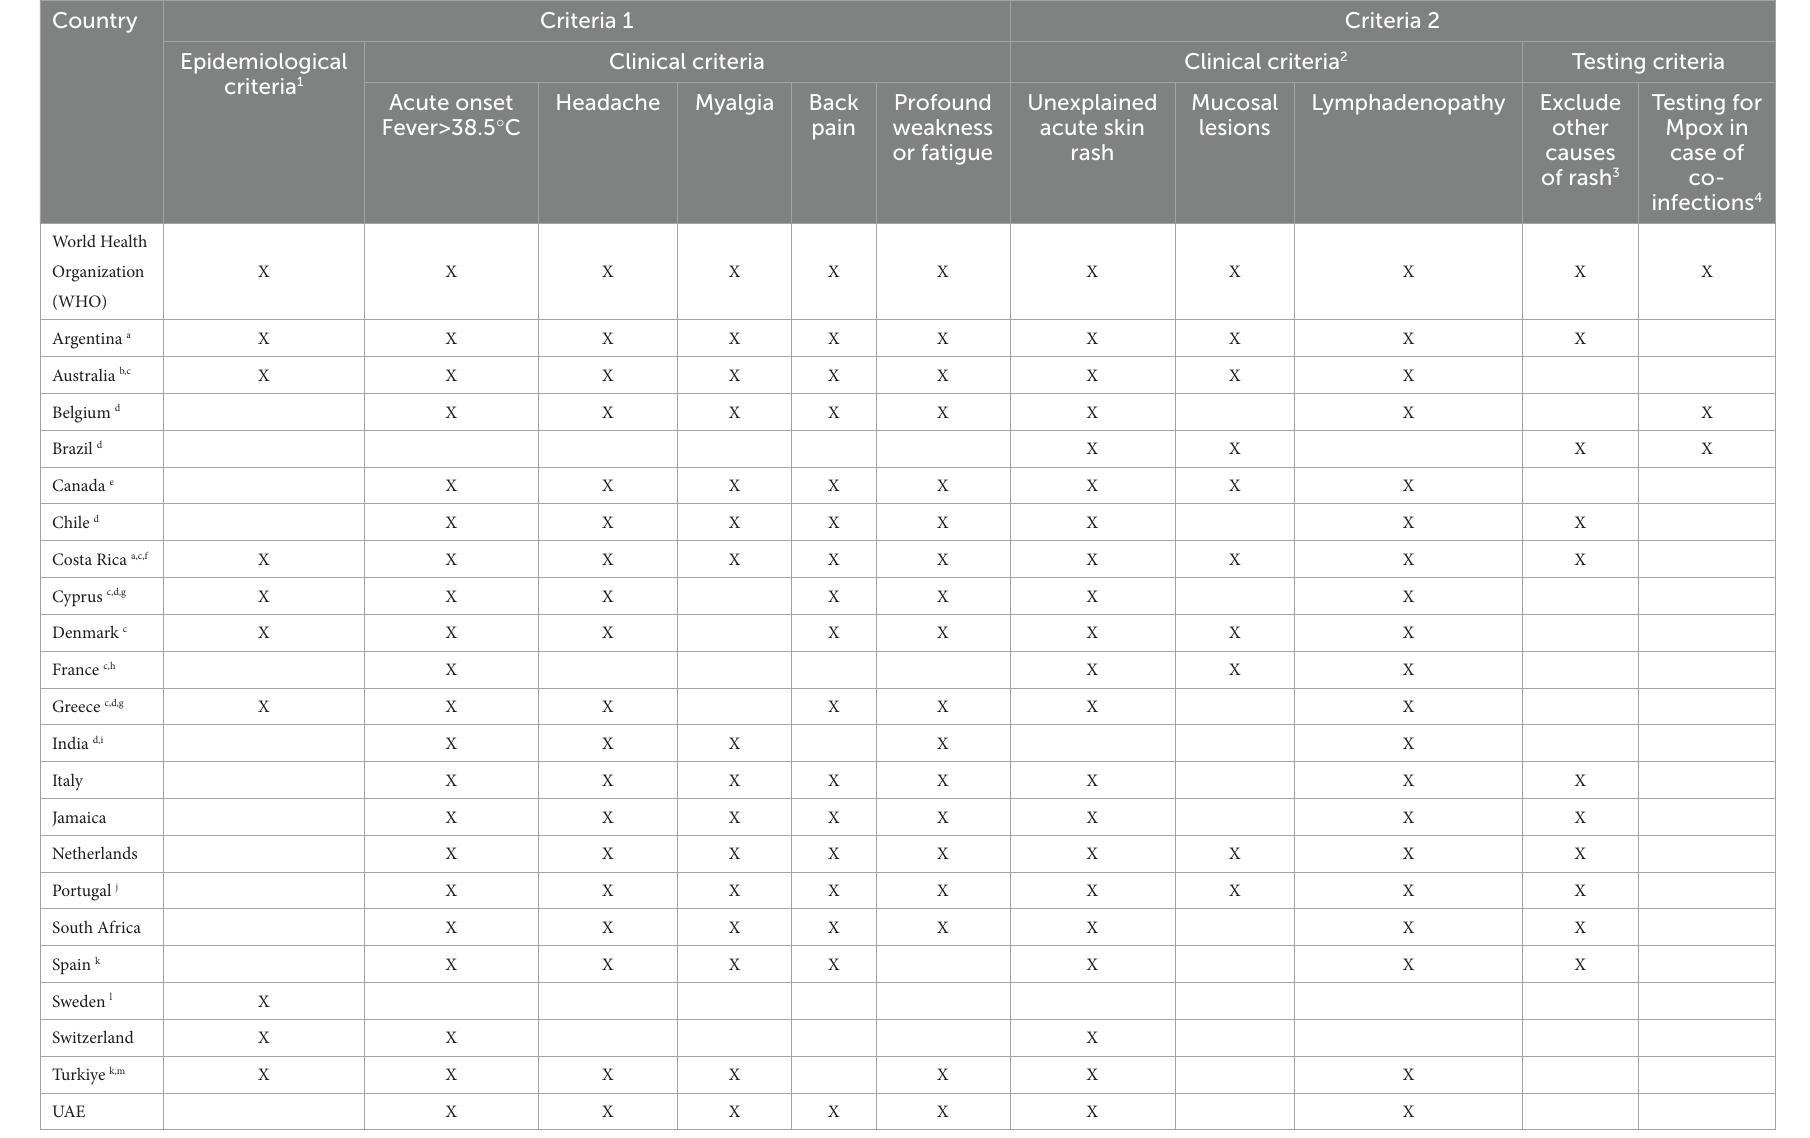
TABLE 3 Criteria for defining Mpox suspected (or possible) case in the investigated